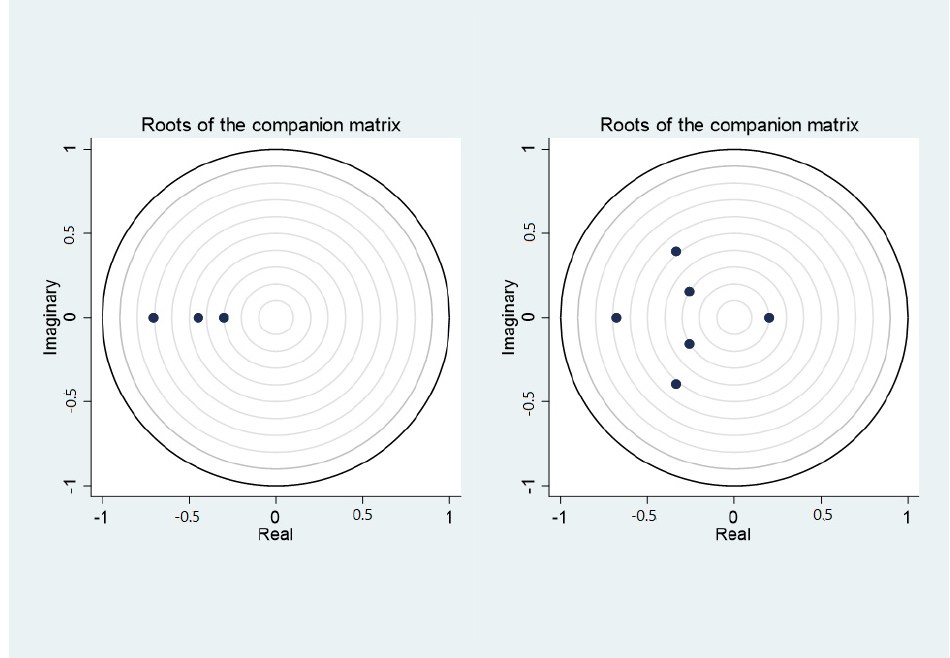
Figure 2. Stationarity test of the PVAR model (the left is the second-order difference first-order lag, and the right is the second-order difference second-order